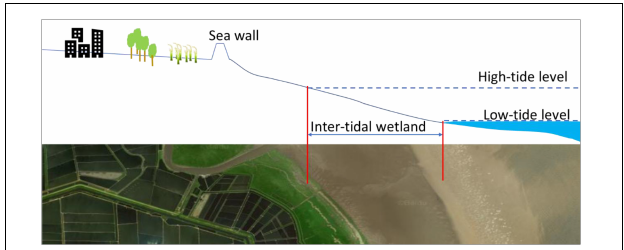
FIGURE 2 | Selection and processing of a satellite image.